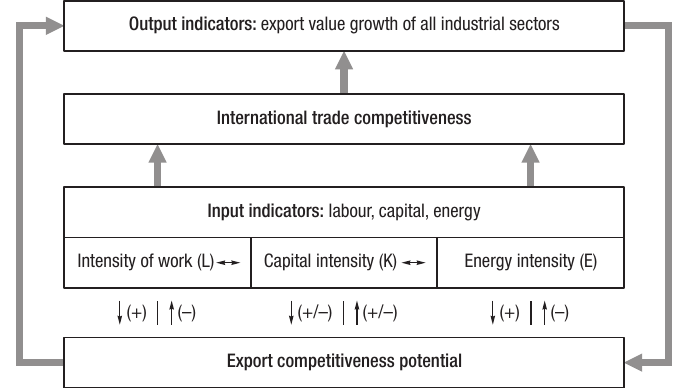
Fig. 11. Research hypothesis: less intensive use but more productive use leads to export competitiveness enhancement (resource intensity aspect)